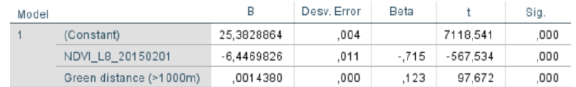
Table 4. Nighttime Air Temperature Model (MODIS,